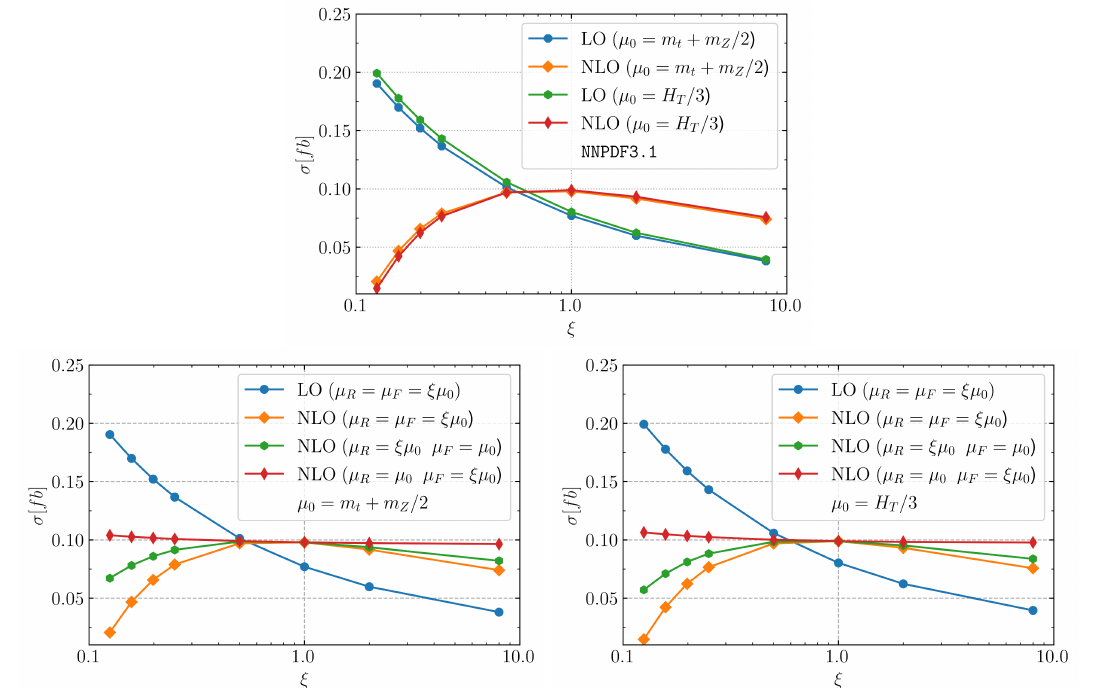
Figure 3 . Scale dependence of the LO and NLO integrated fiducial cross sections for pp → √ e + ν e µ − ¯ ν µ b ¯ b τ + τ − + X at the LHC with s = 13 TeV. In the upper plot renormalisation and factorisation scales are set to µ R = µ F = ξµ 0 where µ 0 = m t + m Z / 2 and µ 0 = H T / 3 . The LO and NLO NNPDF3.1 PDF sets are employed. In the two lower plots, the variation of µ R with fixed µ F and the reverse case are given for each case of µ 0